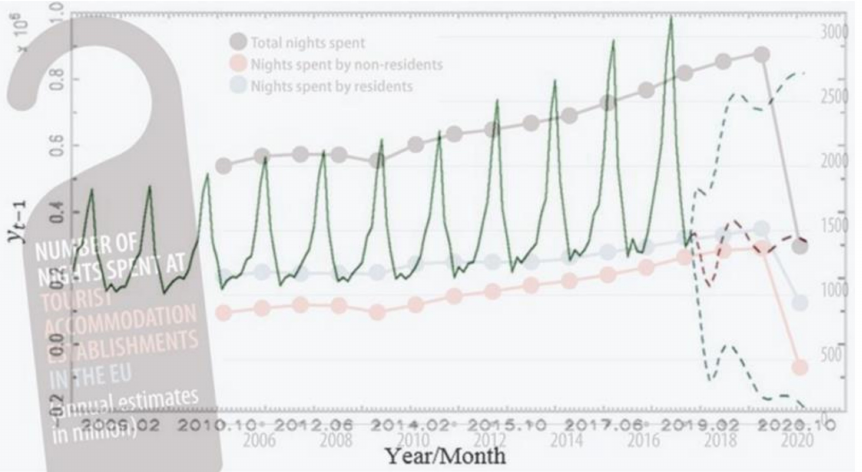
Figure 3. Forecast and realisation of tourist arrivals in overlay images. Source: Authors calculations,